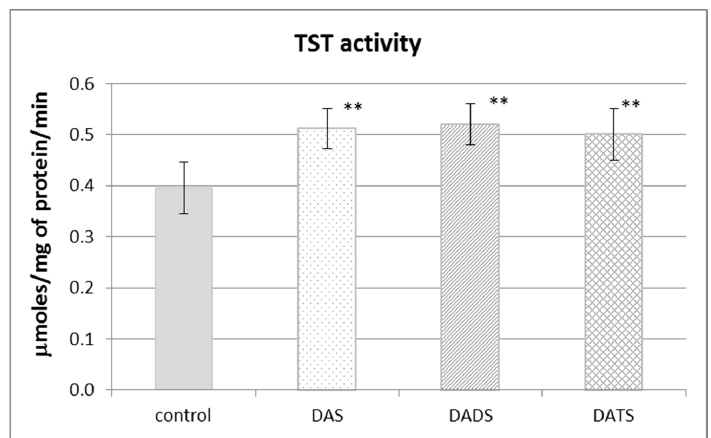
Figure 3. The effect of garlic-derived allyl sulfides (DAS, DADS and DATS) on the activity of rhodanese (TST). Data represent the means of six animals in each group ± SD and are expressed as nmoles per 1 mg of protein per minute. Each assay was performed in triplicate. Statistically significant differences were determined by ANOVA followed by the Fisher test. ** Significantly different from control group ( p < 0.01).